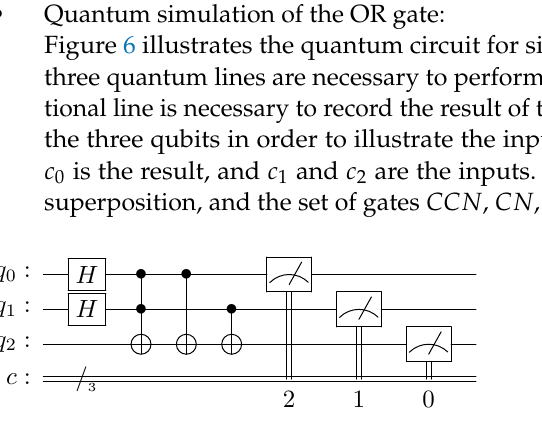
Figure 5. Results for the AND operation.